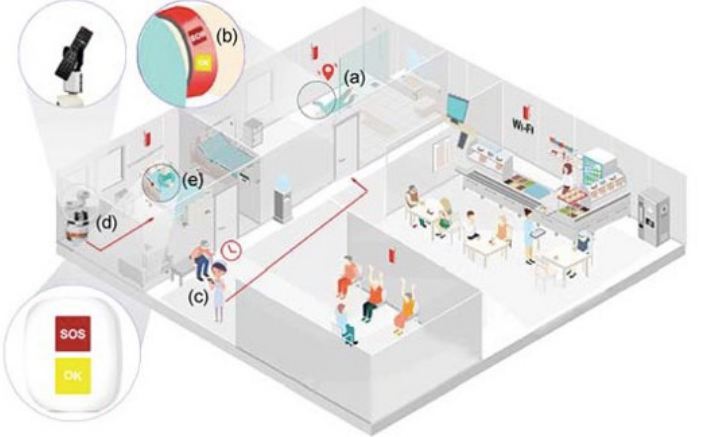
Figure 3. A retirement home (from [20]): heterogeneous sensors can collect data to support the care- givers in their work, while, at the same time, collect valuable data for the indoor localization of both residents and caregivers. The system detects a fallen person through the signal sent by the ( a,b ) Wi-fi bracelet and alerts ( c ) the caregiver. The ( d ) robot assists a ( e ) bedridden resident requesting